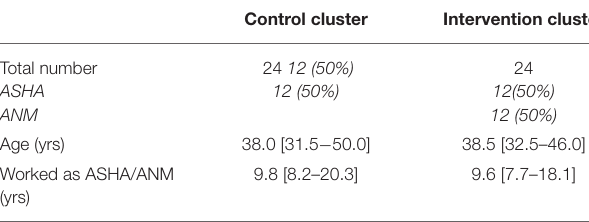
TABLE 1 | Characteristics of the